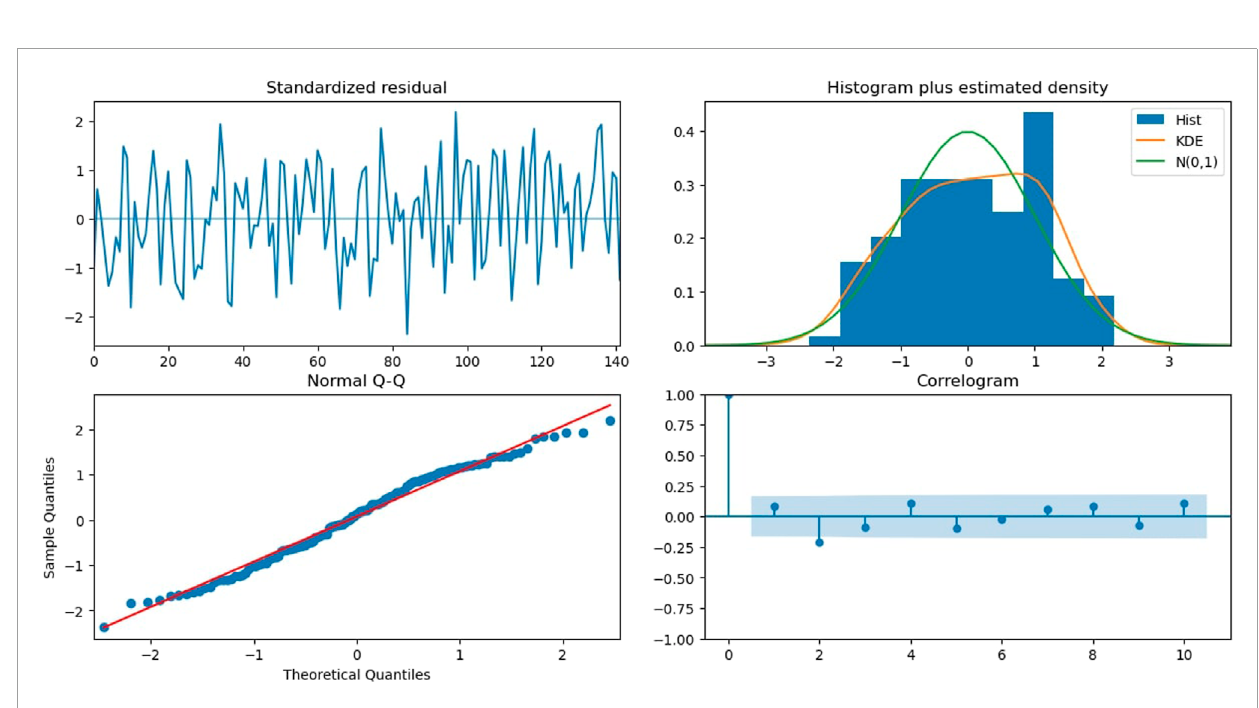
FIGURE 7 Diagnostics for the AR (1)